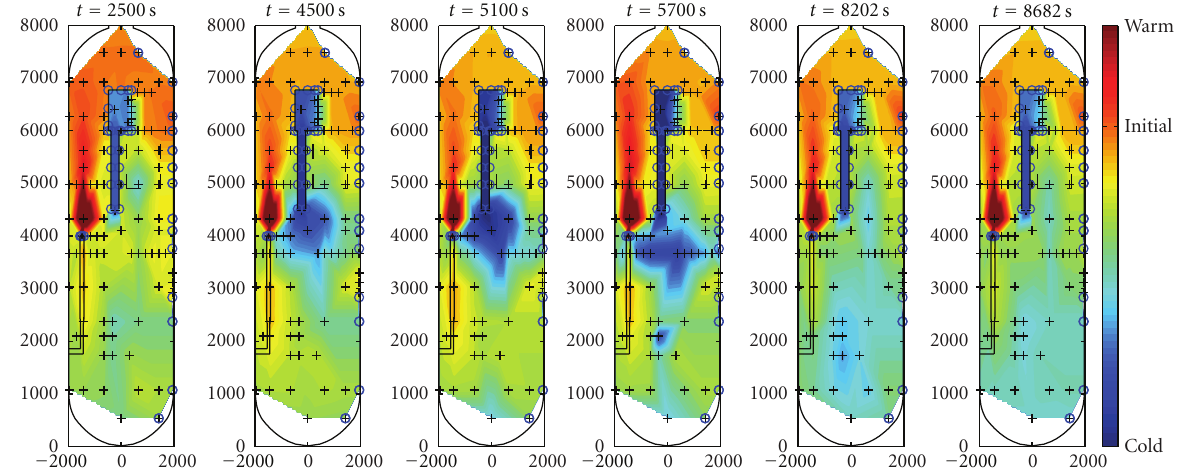
Figure 25: Temperature contour maps in Vessel 1 for experiment ST4 4 for di ff erent instances in time.